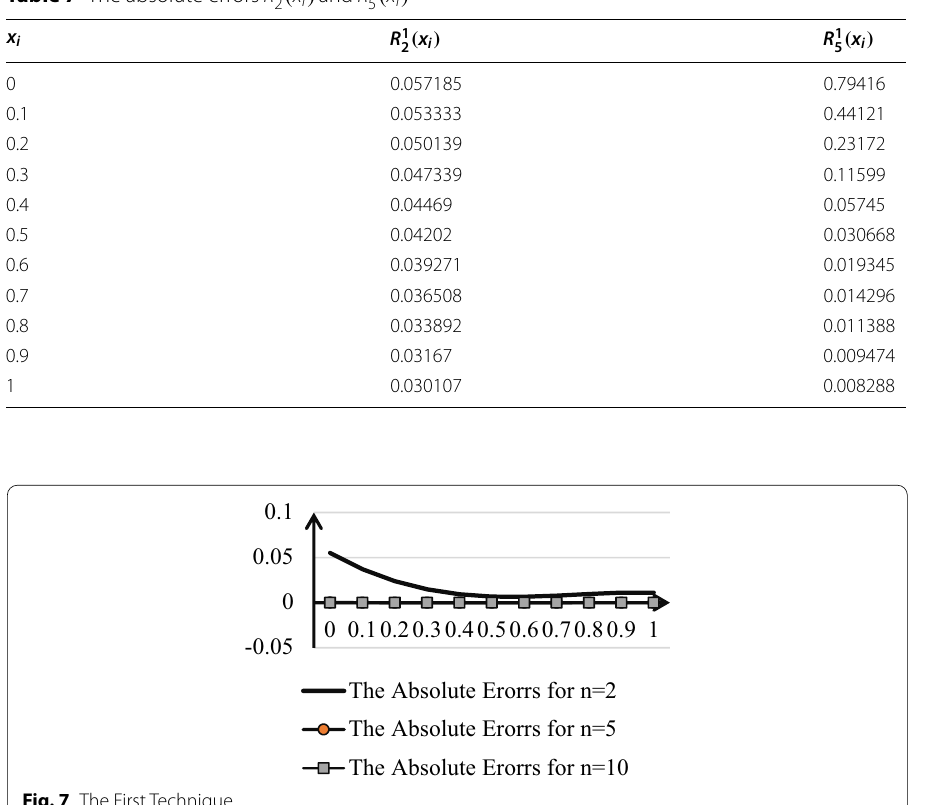
Table 7 The absolute errors R 1 2 ( x i ) and R 1 5 ( x i )